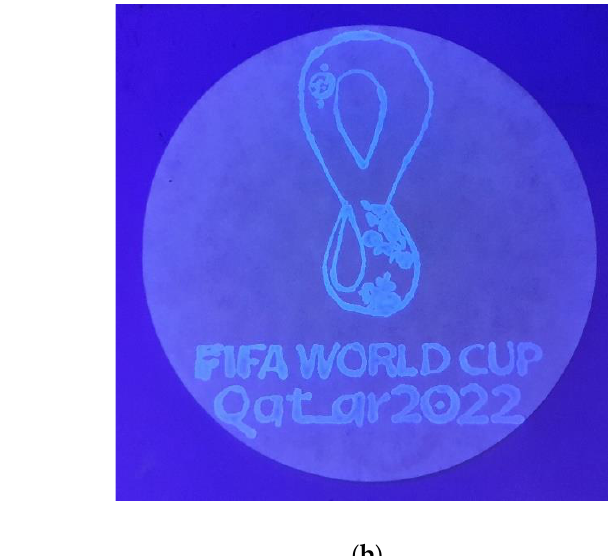
15 of 19 Figure 13. Set I: A: 3APS alone; B: Al(III) alone; C – H: commercial samples only (C and E are Al-free) ( a ). Set II: A: 3APS alone; B: Al(III) + 3APS; C – H: commercial samples + 3APS ( b ).